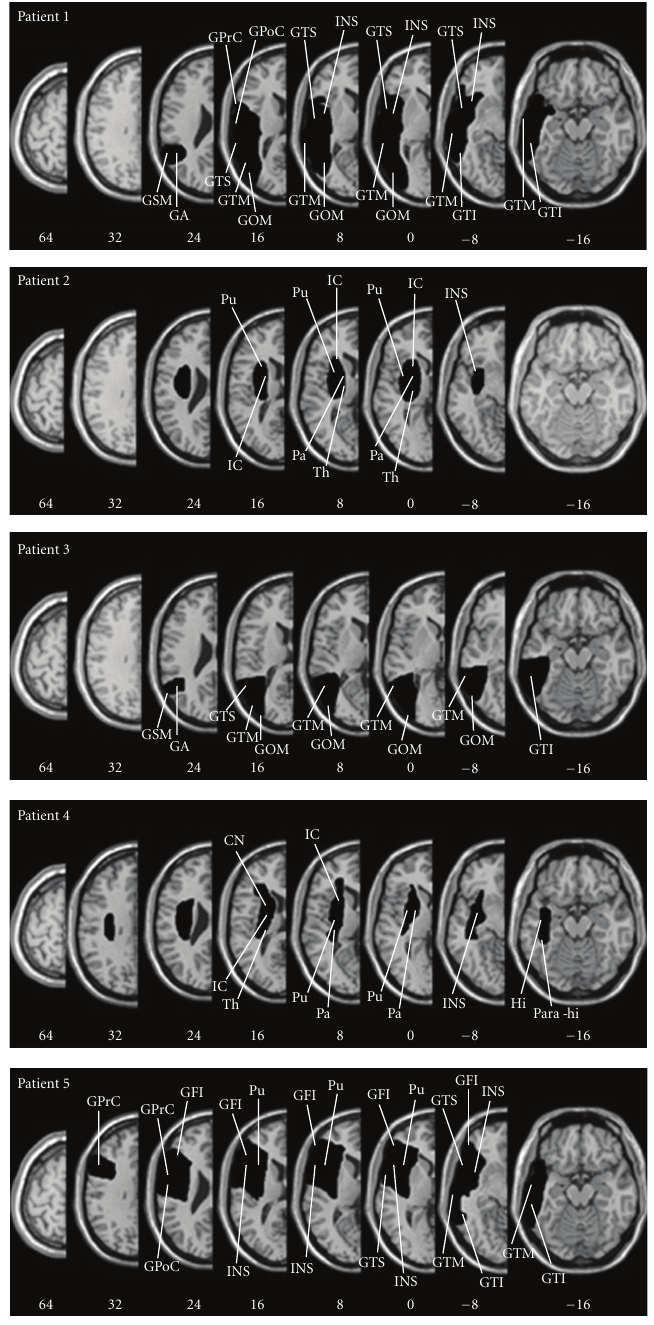
Figure 1: Lesion anatomy. For each patient, all lesions were mapped using the free MRIcro software and were drawn manually on slices of the high-resolution 3D T1-weighted template MRI scan. This template is oriented to match the Talairach space. Lesions were mapped onto the horizontal slices that correspond to Z-coordinates − 16, − 8, 0, 8, 16, 24, 32, 64 in the Talairach space by using the identical or the closest matching horizontal slices of each individual. Following radiological convention, the right cerebral hemisphere is displayed on the left side. Abbreviations : CN, caudate nucleus; GFI, gyrus frontalis inferior; GOM, gyrus occipitalis medius; GPrC, gyrus precentralis; GPoC, gyrus postcentralis; GTM, Gyrus temporalis medius; GTI, gyrus temporalis inferior, GTS, gyrus temporalis superior; Hi, hippocampus; IC, internal capsule; INS, insula; Pa, pallidum; Para-hi, parahippocampus; Pu, putamen; Th, thalamus; GSM, gyrus supra-marginalis; GA, gyrus